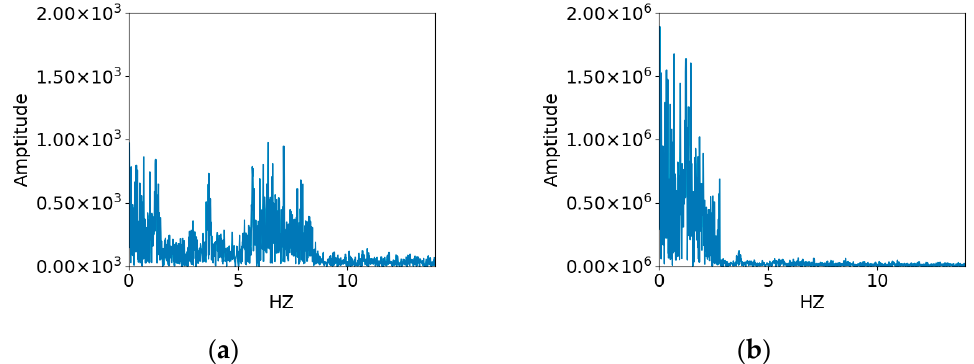
Figure 2. AE signal spectrum in valve well − sealed normal conditions and leakage: ( a ) normal state and ( b ) leaked state.